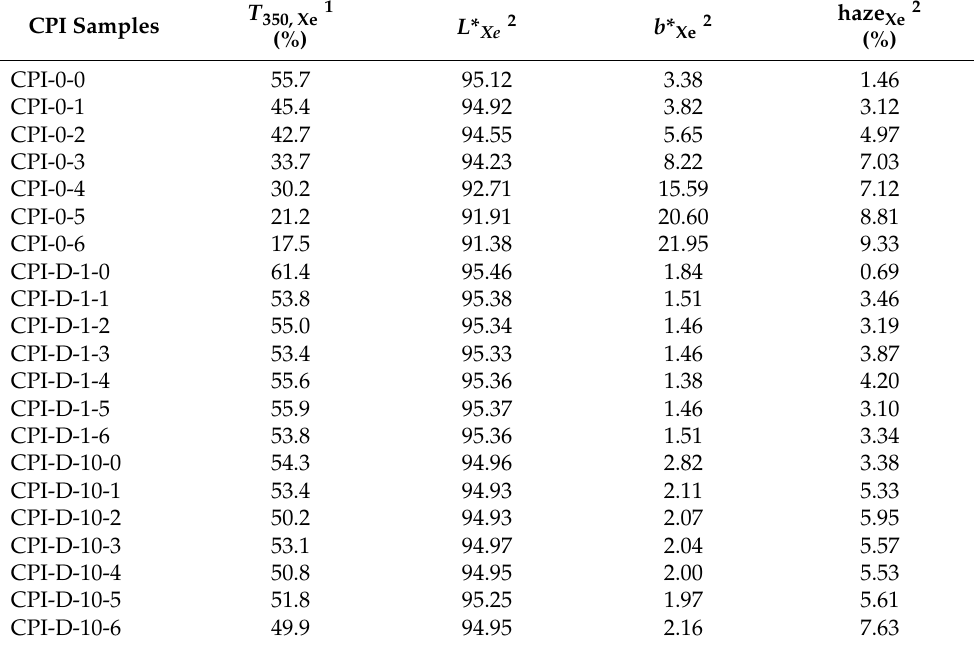
1 T 350,Xe : Transmittance at the wavelength of 350 nm at a thickness of 25 µ m after Xenon lamp exposure; b * Xe , haze Xe : Lightness, yellow indices, and haze for CPI films after Xenon lamp